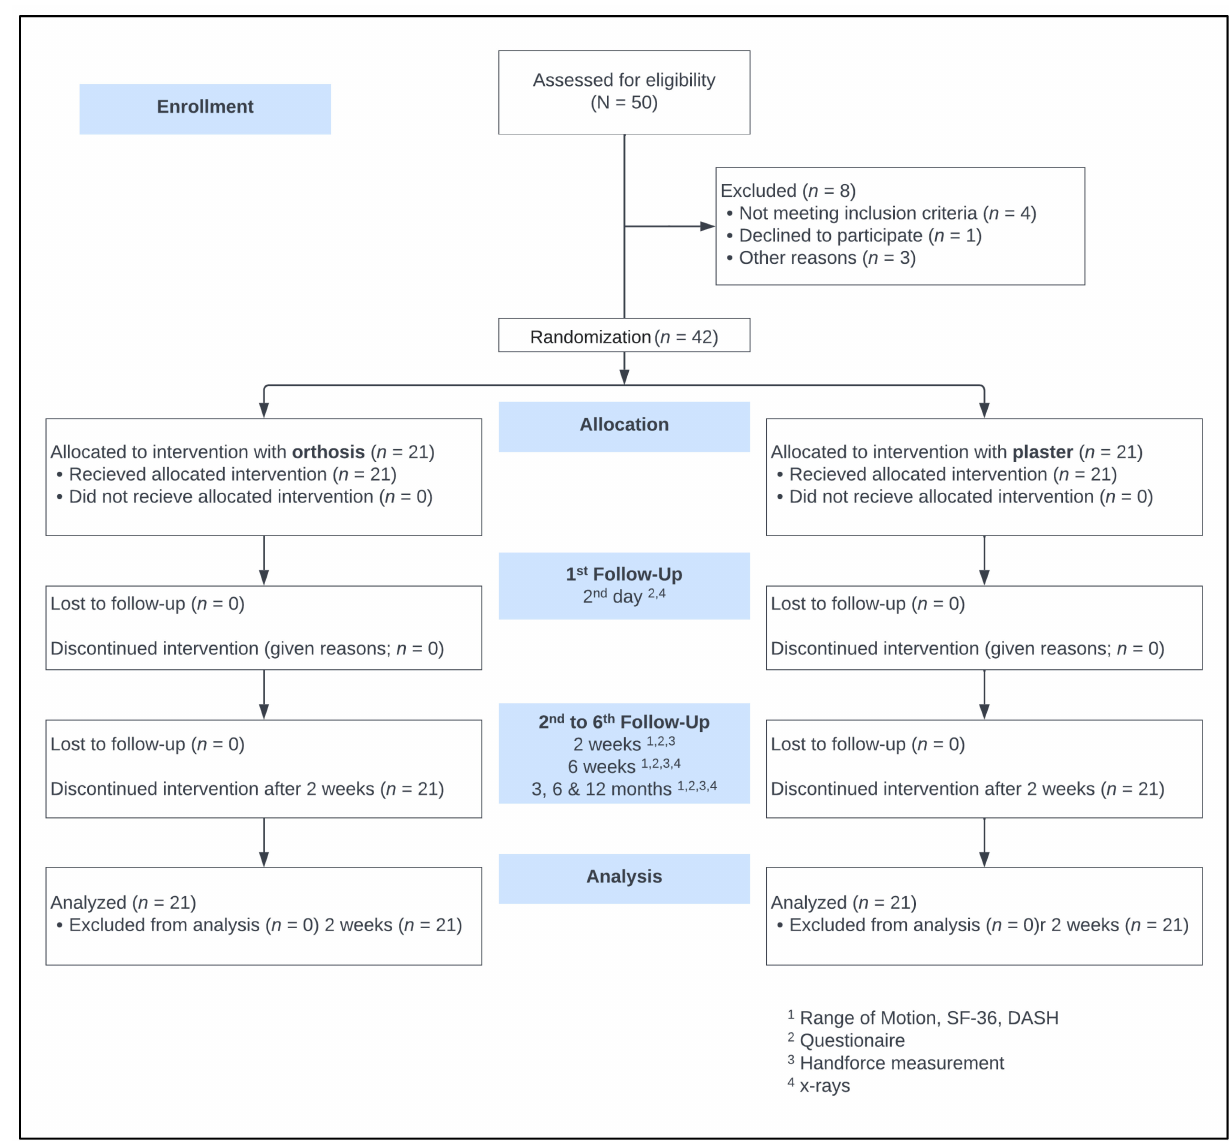
Figure 1. The CONSORT 2010 flow diagram.